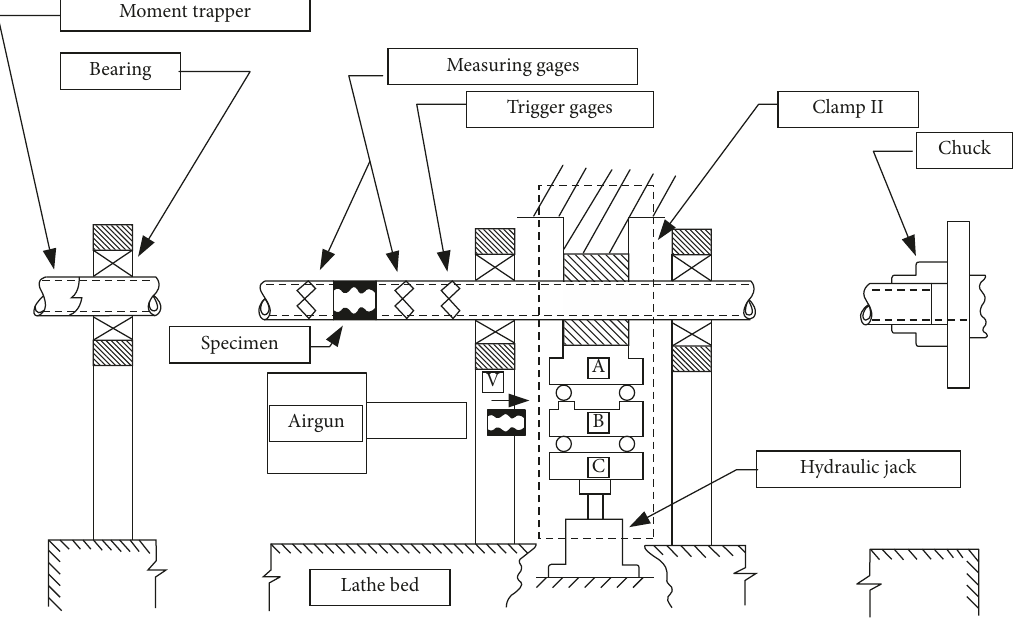
Figure 1: Sketch of the TSHB designed by Baker and Yew [19].